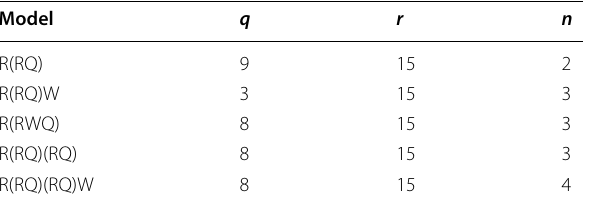
Table 6 Settings of five fractional order unscented Kalman filters